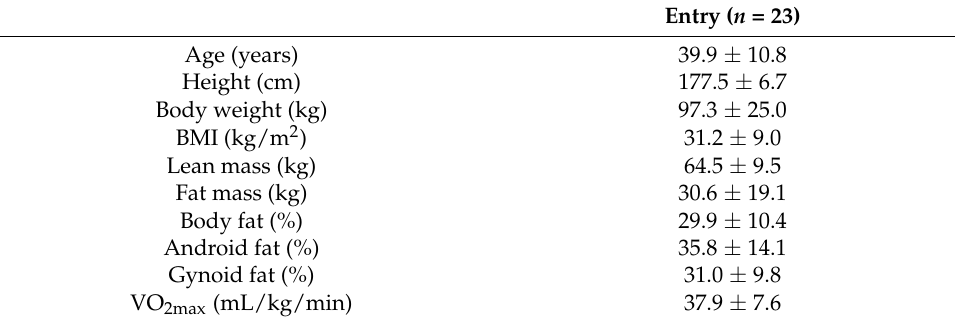
Table 1. Participant demographics at study